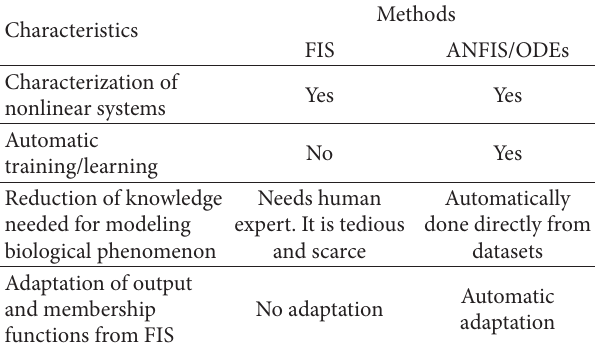
Table 1: Comparison of pure FIS versus ANFIS and